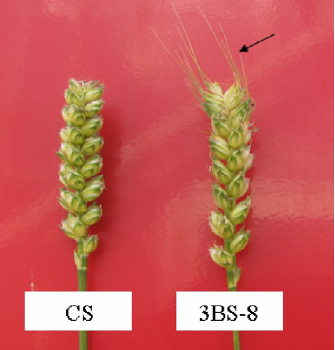
Figure 3. Spikes of euploid Chinese Spring and deletion line 3BS-8 (awns indicated by